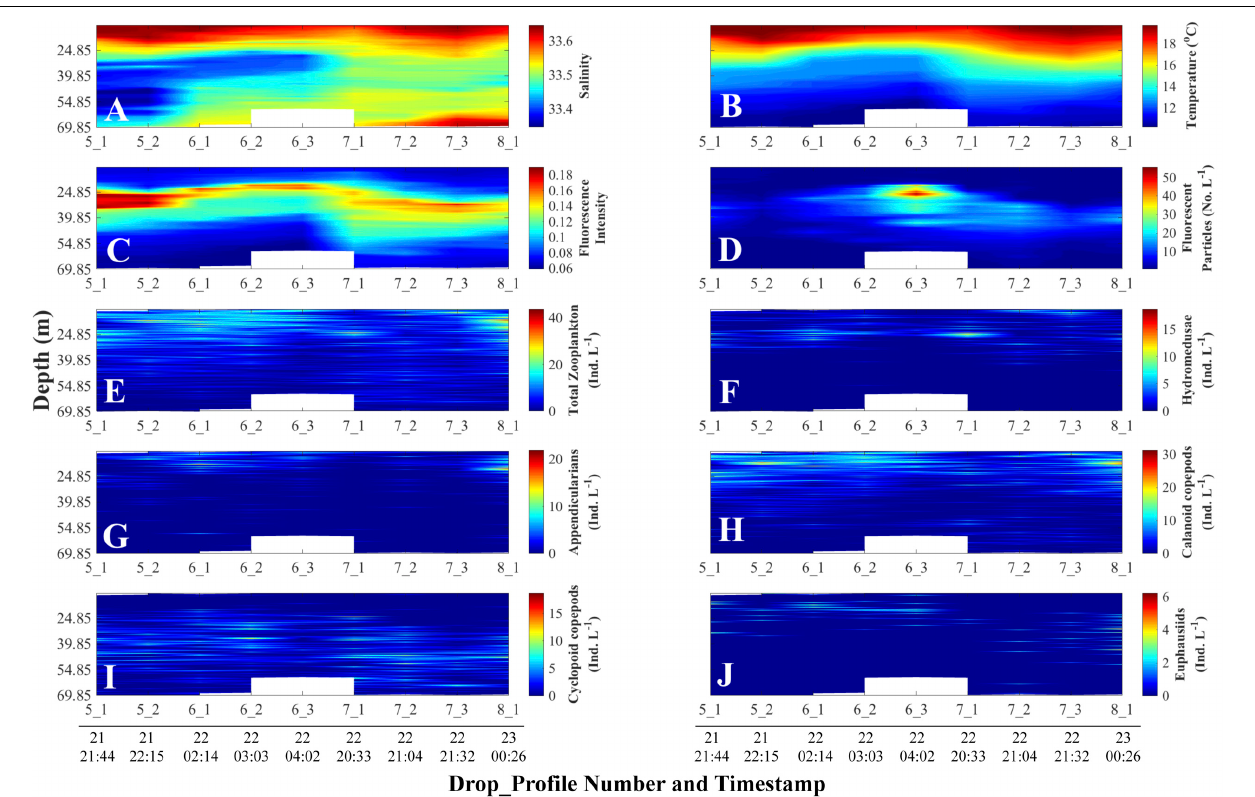
FIGURE 4 | Depth-time distributions of physical and non-normalized biological data. Day and time (all in August 2011, Pacific Standard Time) are at the bottom of each column and apply to all the panels above the line of timestamps. Full details on each Drop_Profile can be found in Table 1 . (A) Salinity; (B) Temperature ( ◦ C); (C) Fluorescence Intensity (SBE 25 fluorometer); (D) Planar Laser Imaging Fluorometer (PLIF) fluorescent particle concentration (Numbers L − 1 ); Panels (E) through (J) represent O-Cam zooplankton concentrations (Individuals L − 1 ): (E) Total zooplankton; (F) Hydromedusae; (G) Appendicularians; (H) Calanoid copepods; (I) Cyclopoid copepods; and (J)